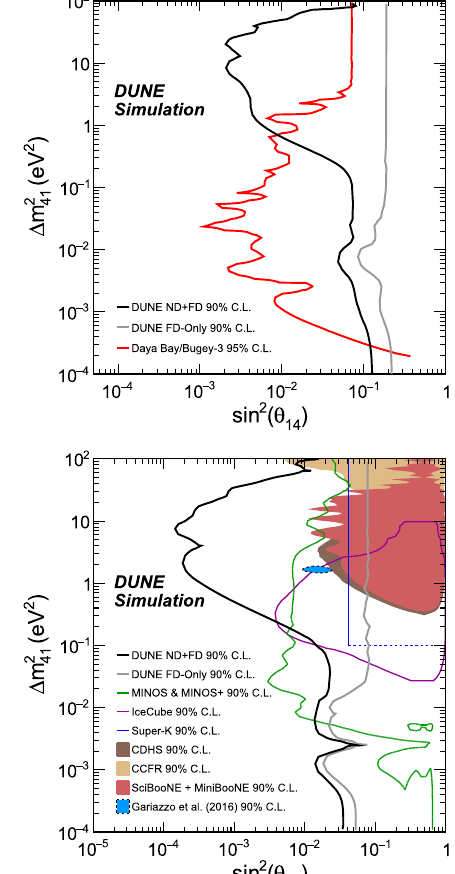
Fig. 2 ThetopplotshowstheDUNEsensitivitiesto θ 14 fromthe ν e CC samples at the ND and FD, along with a comparison with the combined reactor result from Daya Bay and Bugey-3. The bottom plot is adapted from Ref. [18] and displays sensitivities to θ 24 using the ν μ CC and NC samples at both detectors, along with a comparison with previous and existing experiments. In both cases, regions to the right of the contours are excluded